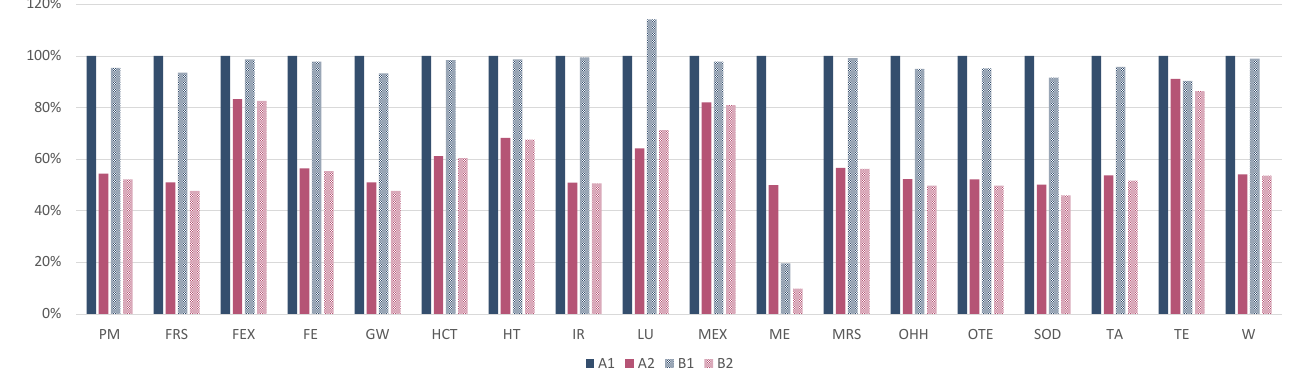
Figure 5. Comparative LCA between CFRP-ff with substitution (scenario A1), CFRP-ff with repair and mechanical recycling (scenario A2), CFRP-ff with repair and thermal recycling (scenario A3), CFRP-bio with substitution (scenario B1), CFRP-bio with repair and mechanical recycling (scenario B2) and CFRP-bio with repair and thermal recycling (scenario B3). Repairing the composite reduces the impact by up to 50% compared to scenarios with substitution. Less reduction in the impact when repairing are shown for the Freshwater, Marine and Terrestrial Ecotoxicity impact categories. The substitution of the curing agent slightly contributed to reducing the impacts among all the categories. The same occurs comparing mechanical and thermal